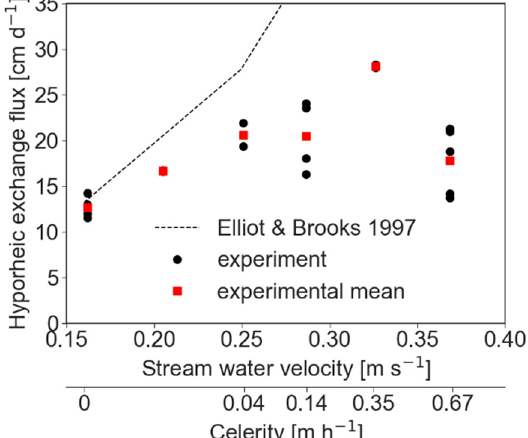
Figure 1. Relationship between HEF and stream water velocity and bed form celerity (bed form celerity axis is not scaled). The dashed line shows modelled results for stationary bed forms by including only the effect of pumping. The predicted exchange continuously increases in a linear manner until it reaches 74 cm·s − 1 under the stream water velocity of 0.37 m·s − 1 (data not shown).